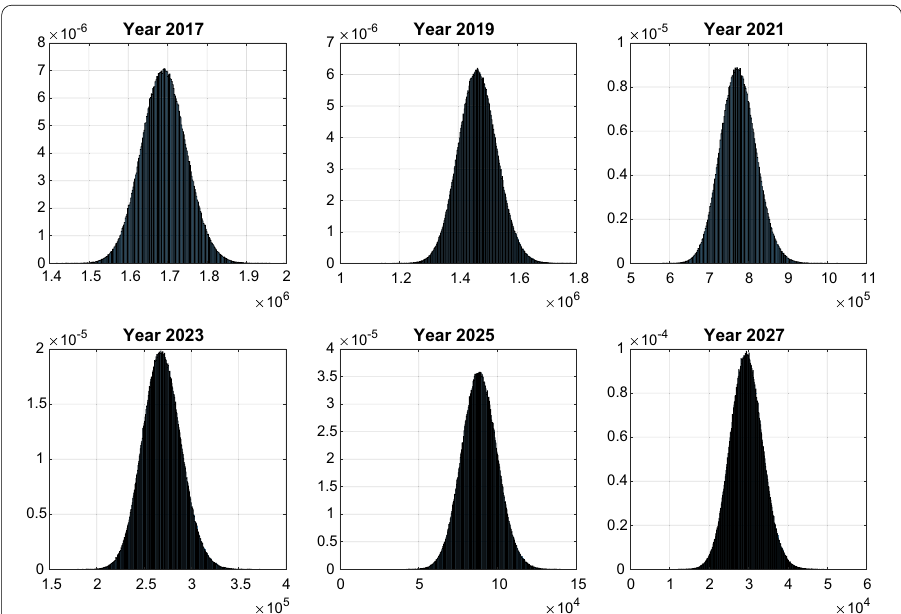
Fig. 1 Histogram of unpaid losses (Bodily